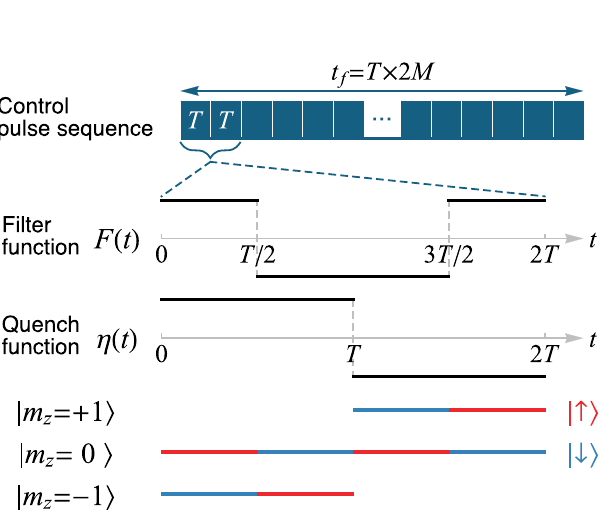
Fig. 6 Schematic for example NV center control pulse sequence realizing time modulations in both the noise fi lter function F ( t ) and quench function η ( t ). As shown in Eqs. (38) and (39), this control sequence in turn enables reconstruction of spectral function J ½ ω (cid:5) . The control pulses are periodically structured as 2 M repetitions of a base sequence (period T = t f / 2 M ), so that F ( t ) and η ( t ) have period 2 T = t f / M . The noise fi lter function F ( t ) encodes timings of the standard dynamical-decoupling π -pulses within the qubit subspace. In addition, we can further engineer a modulating quench function η ( t ) by periodically switching between qubit subspaces of { m z = 0, m z = − 1} and { m z = 0, m z = + 1} (see also Table 1). The corresponding time-dependent NV levels used as sensor qubit states during the protocol are illustrated in the bottom part of the